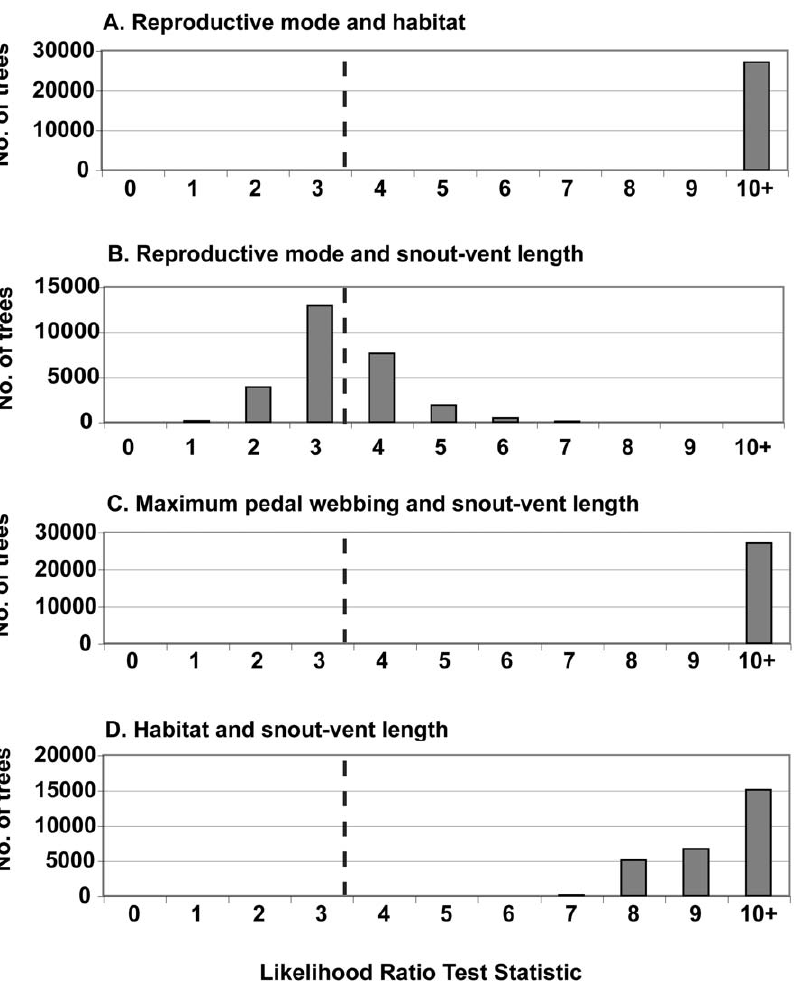
Figure 3. Results of selected correlation tests between pairs of binary characters using BayesTraits. Frequency distributions of likelihood-ratio values were estimated from 27,000 trees (post burn-in trees obtained from *BEAST). Dashed lines indicate significant p -values at the 5% threshold. (a) Reproductive mode and adult habitat; (b) reproductive mode and snout-vent length; (c) maximum pedal webbing and snout-vent length; (d) adult habitat and snout-vent length.